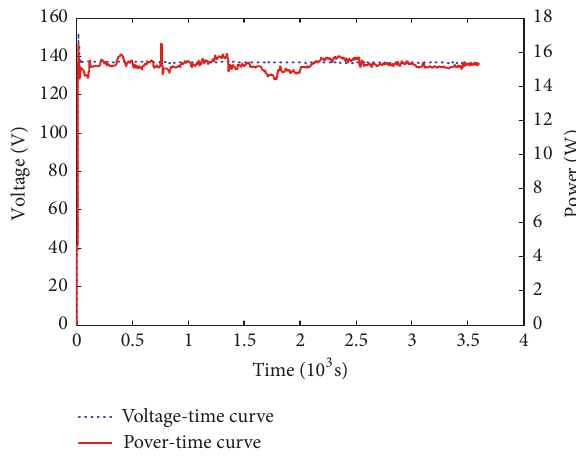
Figure 14: The power consumption of the